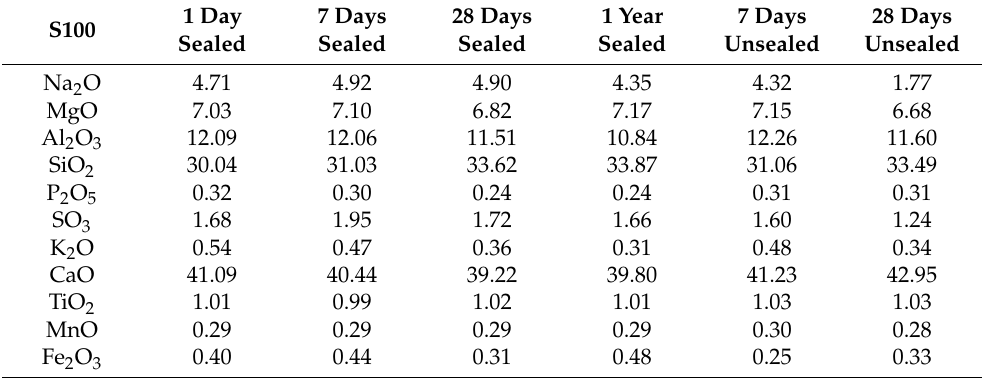
Table 10. Bulk chemistry obtained with PARC for the paste S100.